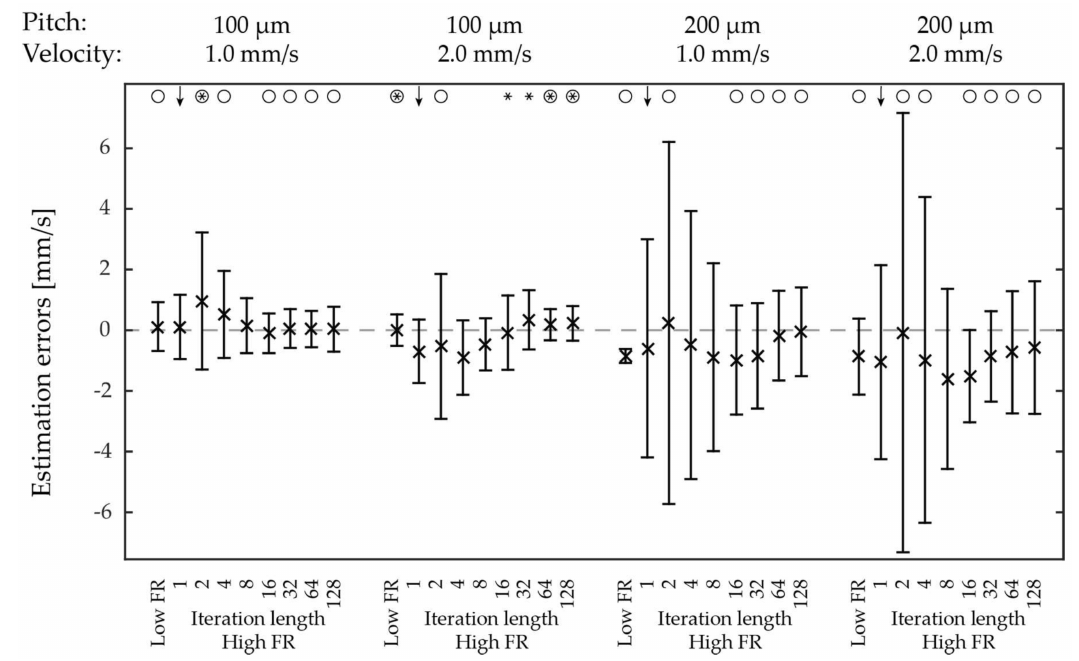
Figure 4. Lateral estimation errors of the velocity for two different velocities each using two different pitches (100 µ m and 200 µ m). The crosses indicate the mean estimation error with the error bars indicating ± one standard deviation. Significant changes ( p < 0.05) were calculated compared to k = 1 in each setting (marked with an arrow). The star indicates a change in mean estimation error and a circle indicates a change in the standard deviation. FR signifies frame rate: low = 41 Hz, high = 1302 Hz.